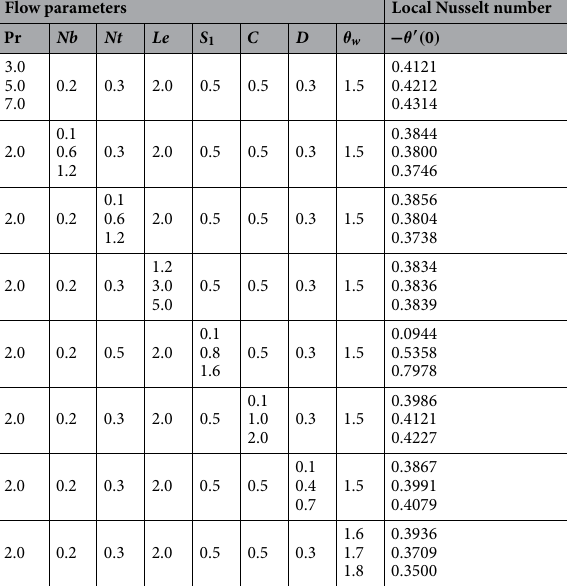
θ ′ ( 0 ) versus flow parameters. −